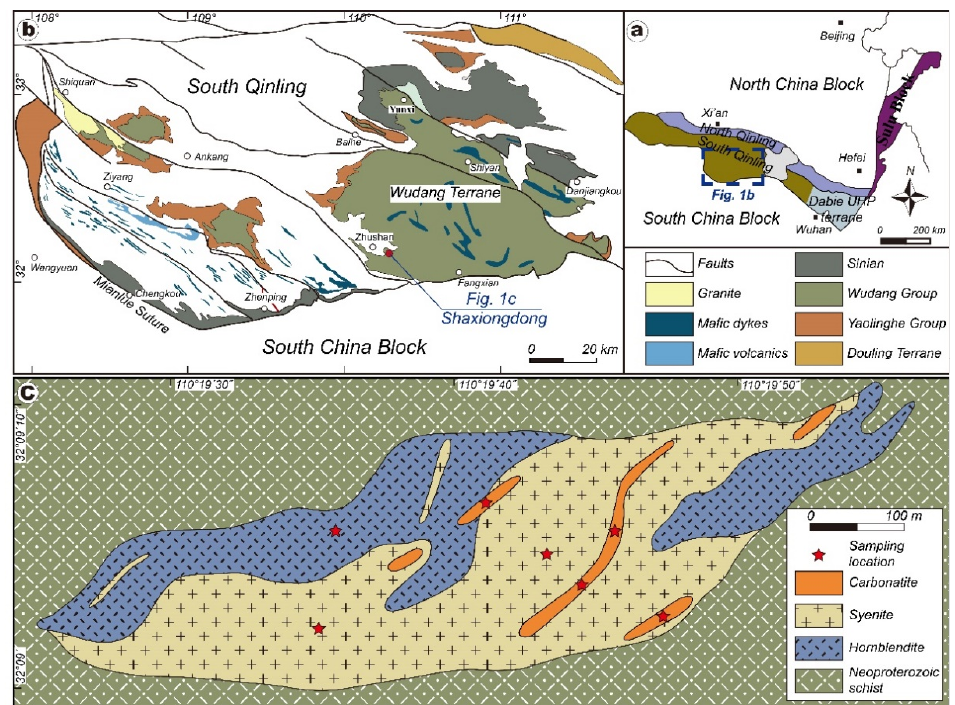
Figure 1. ( a ) Major tectonic units in Eastern China and the location of the South Qinling Belt; ( b ) simplified map showing the locality of the SXD complex within the South Qinling Belt (modified from [47] ); ( c ) geological map of the SXD complex with the distribution of different lithologies. The SXD alkaline–carbonatite complex, located around 12 km southeast of Zhushan County, Western Hubei Province, is tectonically situated at the southern margin of the Wudang terrane. It occurs as a spindle-like stock intruding on the Wudang Neoprotero- blendite outcropping in the northwestern and eastern parts of the intrusion and syenite